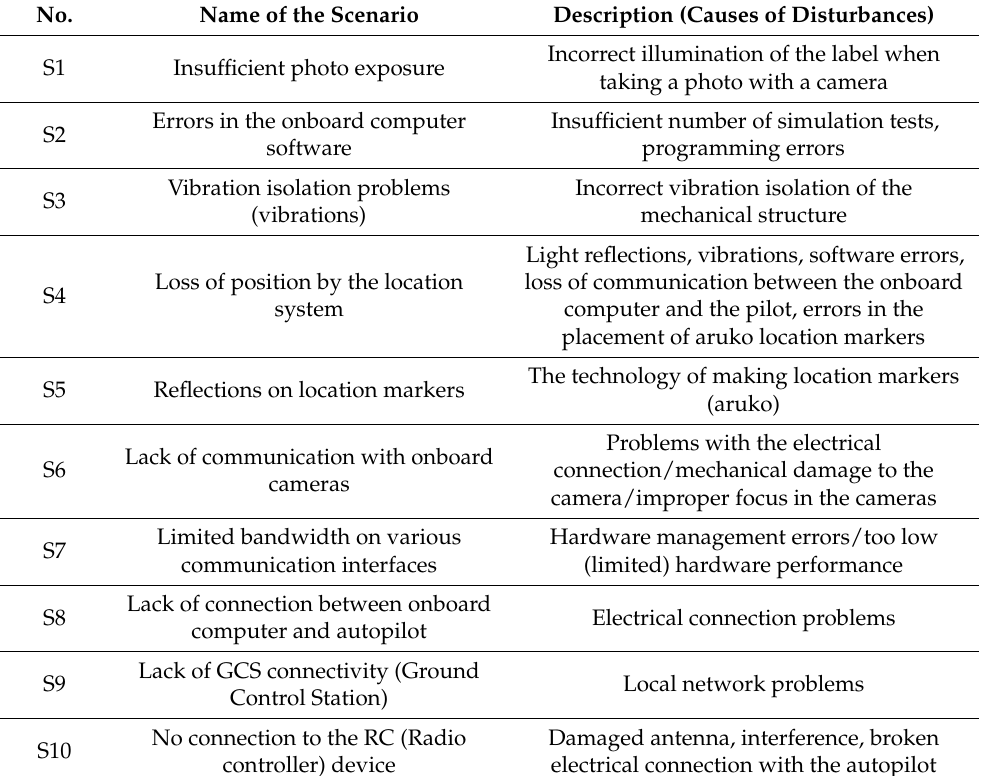
Table 4. Description of the scenarios subject to the risk assessment.